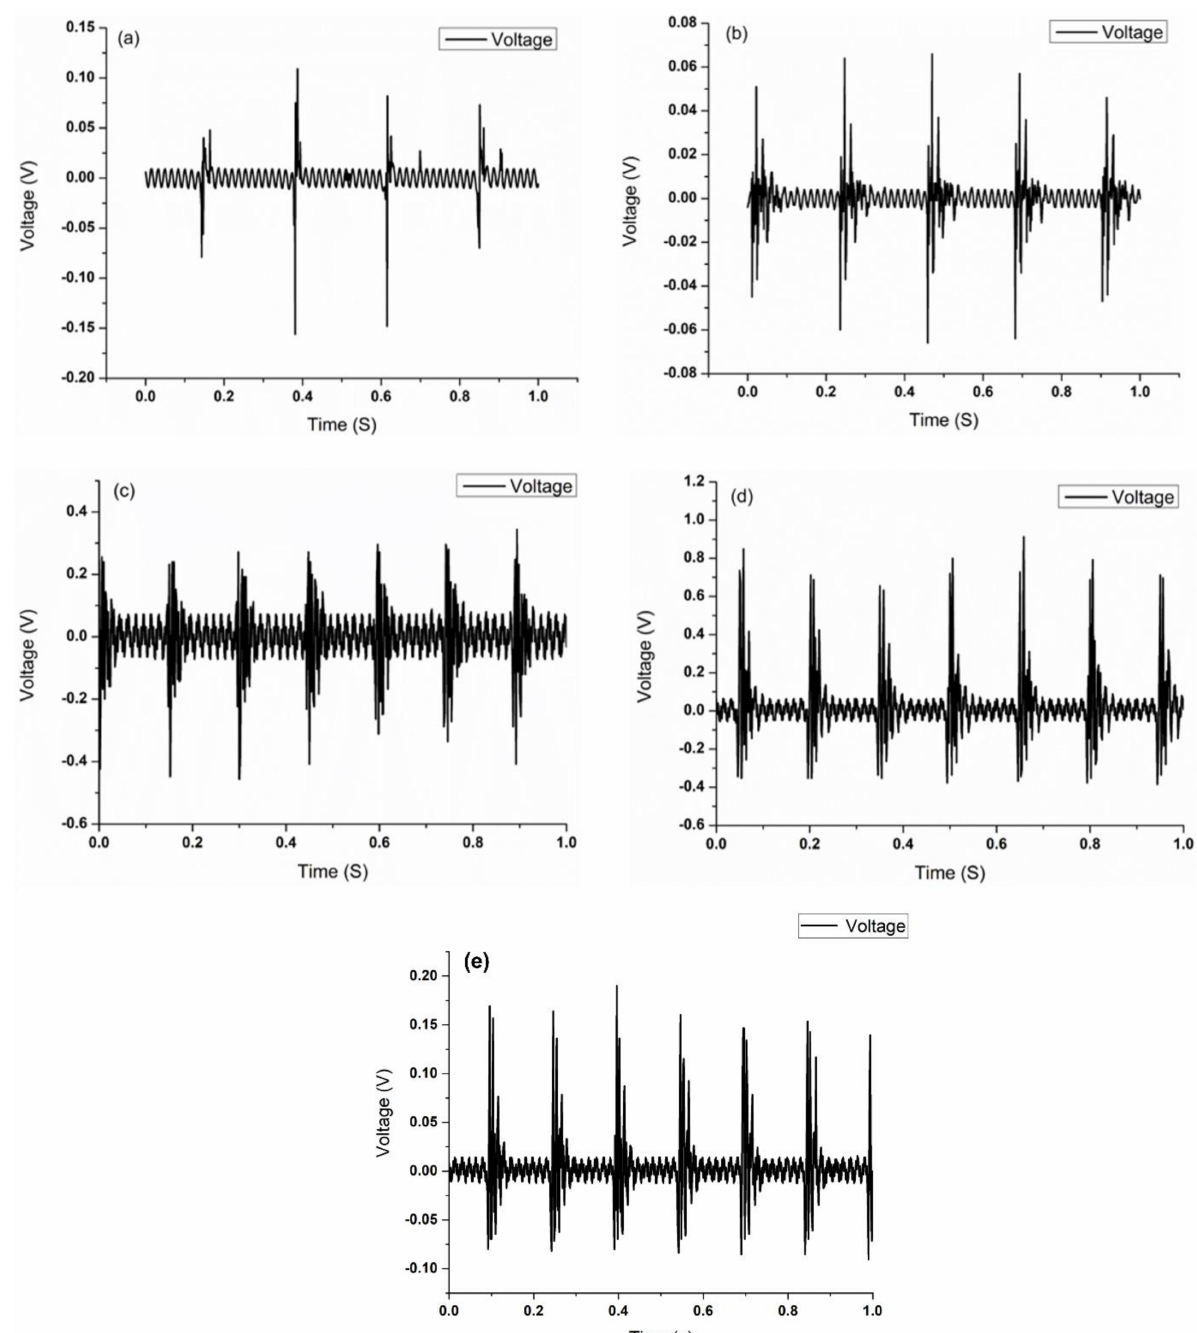
Figure 9. Piezoelectric properties (voltage output) of PVDF fibers with 6% Ag nanoparticles: tapped ( a ) at 4 Hz; ( b ) at 5 Hz; ( c ) at 6 Hz, ( d ) at 7 Hz, and ( e ) without Ag